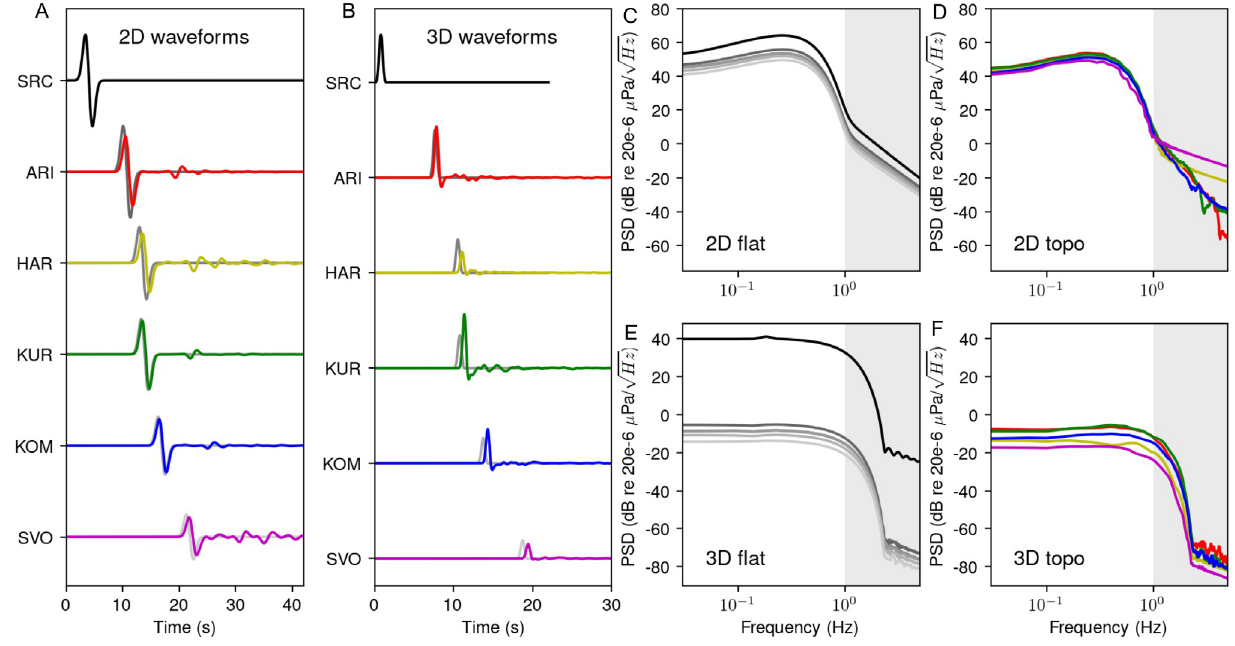
Figure 4: Synthetic waveforms and spectra for comparable 2D cylindrical and 3D Cartesian modeling methods. [A] Synthetic waveforms from 2D modeling with topography (color) and flat ground (grey scale). Amplitudes are normalized for ease of visualization; the source function (SRC) is normalized by the maximum at SRC while all other waveforms are normalized by the maximum at ARI with flat ground. [B] Synthetic waveforms from 3D modeling with topography [color; Kim and Lees 2014] and with a free field (grey scale). Free field values are multiplied by two to approximate flat ground. Amplitudes are normalized in the same manner as Figure 4A. Multitaper PSD estimates are shown for synthetic wavefroms from [C] 2D flat ground simulations; [D] 2D topography simulations; [E] 3D free field simulations; [F] 3D topography simulations. Grey shaded regions indicate frequencies above 1 Hz (maximum source frequency) for which results may be inaccurate.